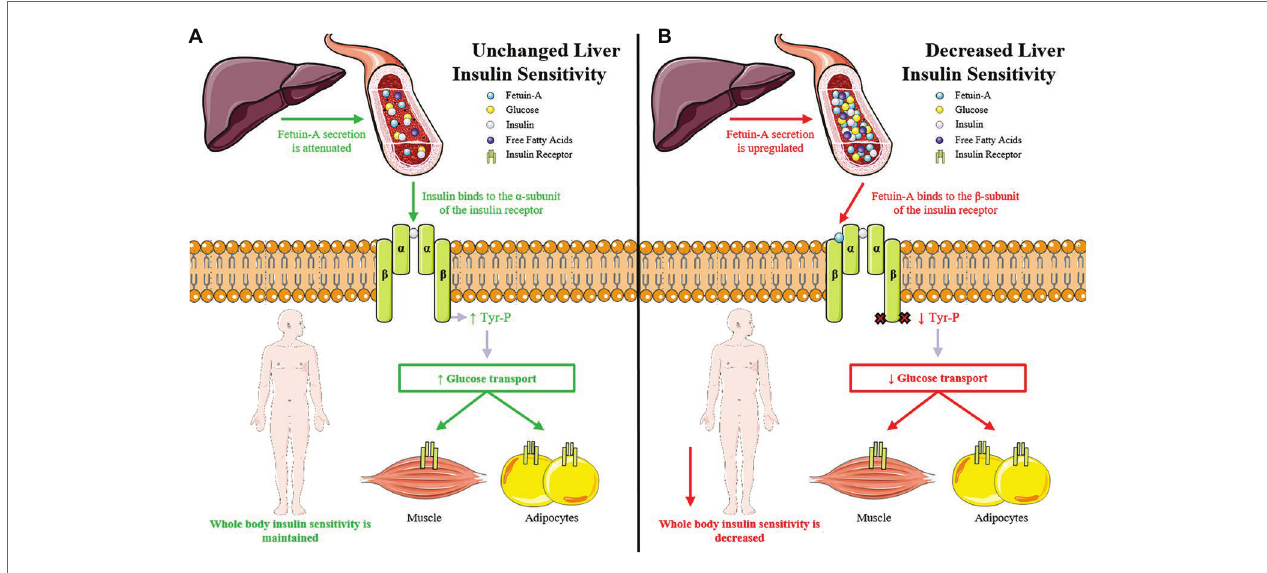
FIGURE 3 | The impact of liver insulin sensitivity and fetuin-A secretion on whole body insulin sensitivity. (A) Unchanged liver insulin sensitivity: if liver insulin sensitivity is unchanged then the release of fetuin-A from the liver is attenuated. This allows insulin to bind to the α -subunit of the insulin receptor, which promotes the auto- phosphorylation of the insulin receptor and subsequent tyrosine phosphorylation of the insulin receptor substrate (IRS) proteins. These actions initiate a cascade of events leading to increased glucose uptake in peripheral tissues and an improvement in whole body insulin sensitivity. (B) Decreased liver insulin sensitivity: when liver insulin sensitivity is decreased, the release of fetuin-A from the liver is upregulated. Fetuin-A binds to the extracellular portion of the β -subunit of the insulin receptor. Fetuin-A inhibits insulin receptor auto-phosphorylation and tyrosine kinase activity leading to decreased glucose uptake in peripheral tissues and a reduction in whole body insulin